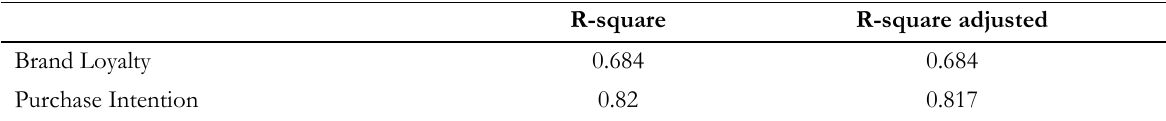
Table 4: R-square